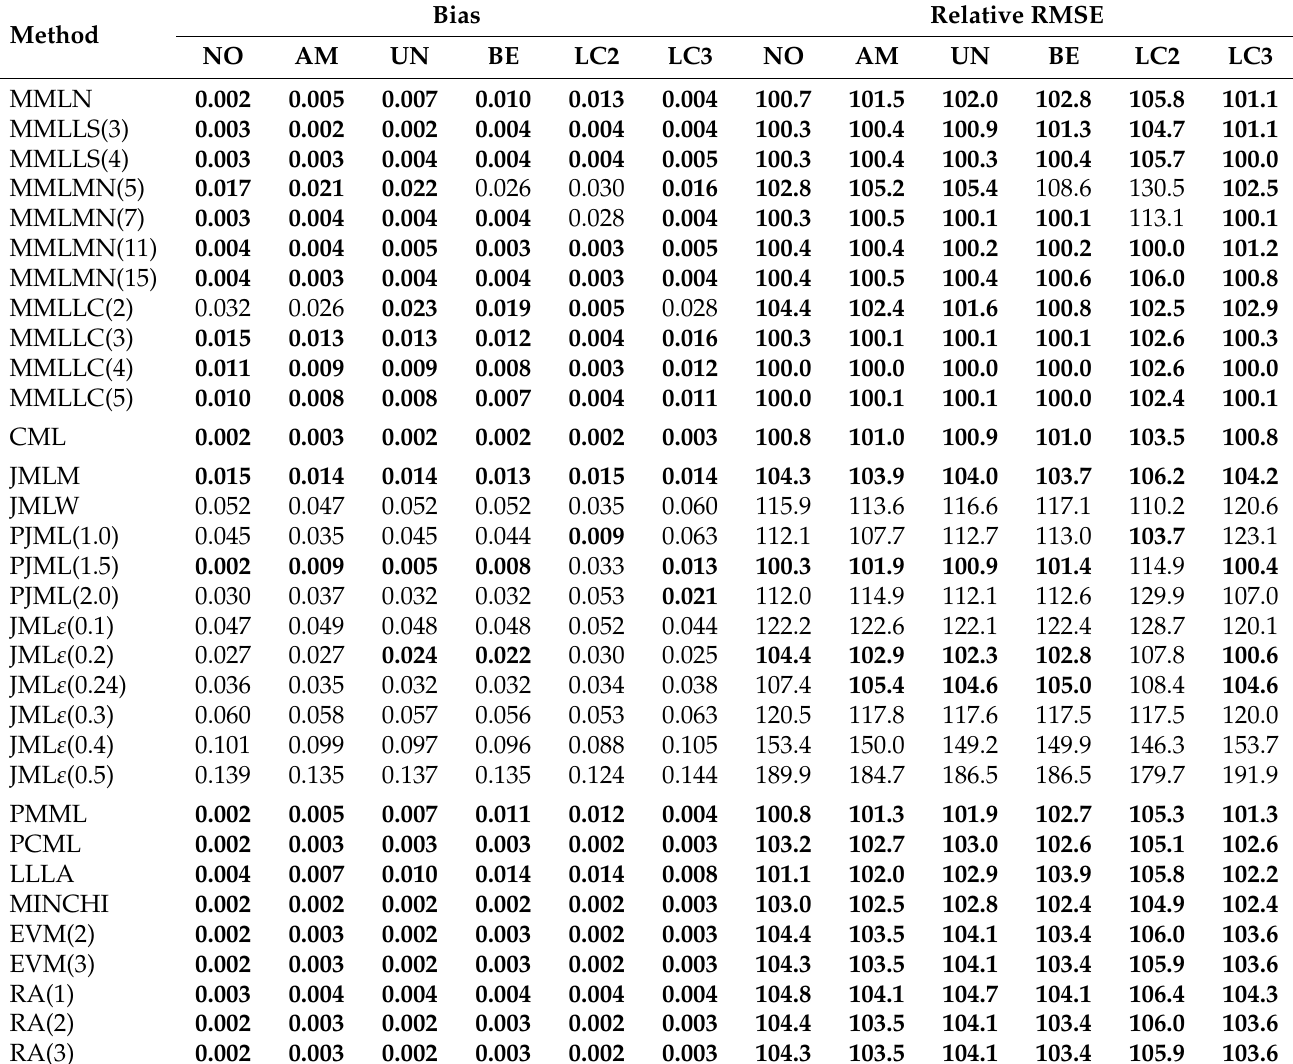
Table A3 shows the bias and the RMSE for different estimation methods for a sample size of N = 1000 and I = 30 items for a test with a wide range of symmetrically distributed item difficulties as a function of the data-generating trait distribution. Table A1. Bias and relative RMSE for different estimation methods for a sample size of N = 1000 and I = 10 items for a test with a small range of symmetrically distributed item difficulties as a function of the data-generating trait